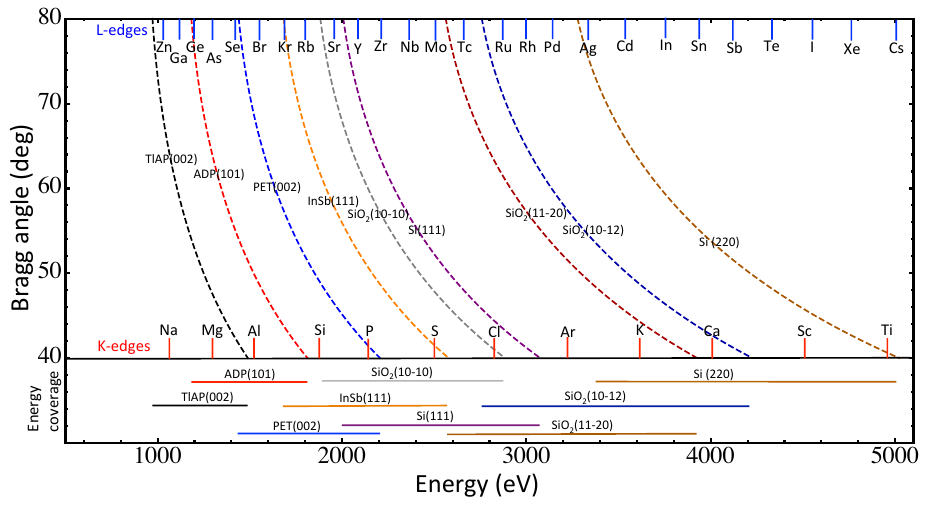
Figure 16. The tender X-ray energy range covered by the ESA Prime X-ray spectrometer. The dashed lines are the various crystals available for use with the spectrometer (see Table 3), covering the full range of energies at the various Bragg angles available in the spectrometer. The energies of various X-ray emission transitions are also marked to provide a sense as to what elements can be measured in this photon energy range.